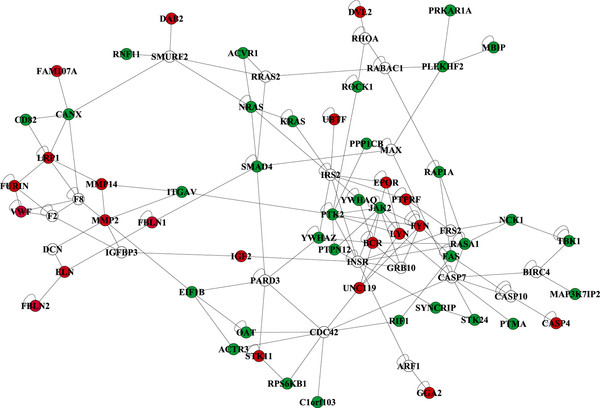
Interaction subnetwork of potential arterial disease-associated genes in patients with type 2 diabetes. The subnetwork consists of 74 nodes and 166 edges. Red nodes represent upregulated genes, green nodes represent downregulated genes (P < 0.05), and white nodes represent genes with P > 0.05. The z-score of the network is 9.23 (permute P = 0.01)